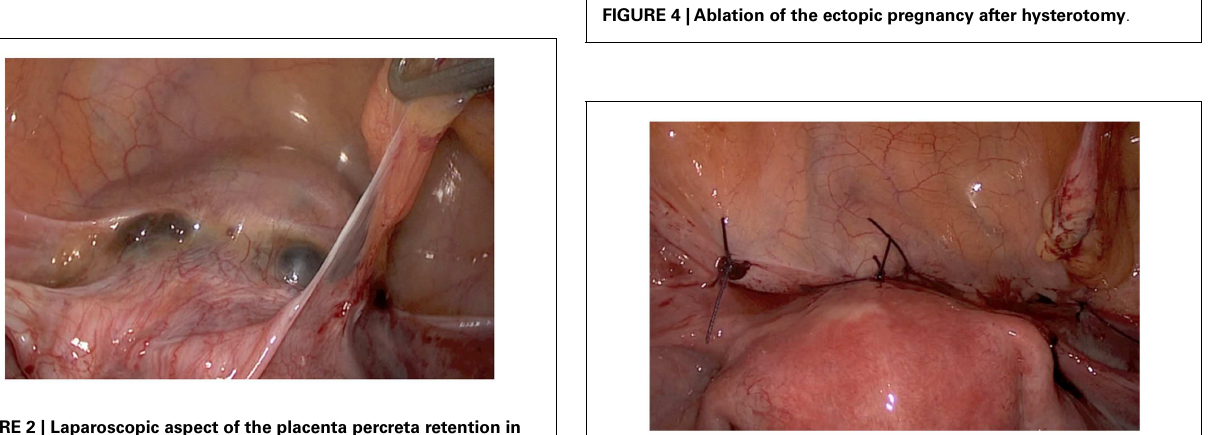
FIGURE 2 | Laparoscopic aspect of the placenta percreta retention in the cesarean section scar .